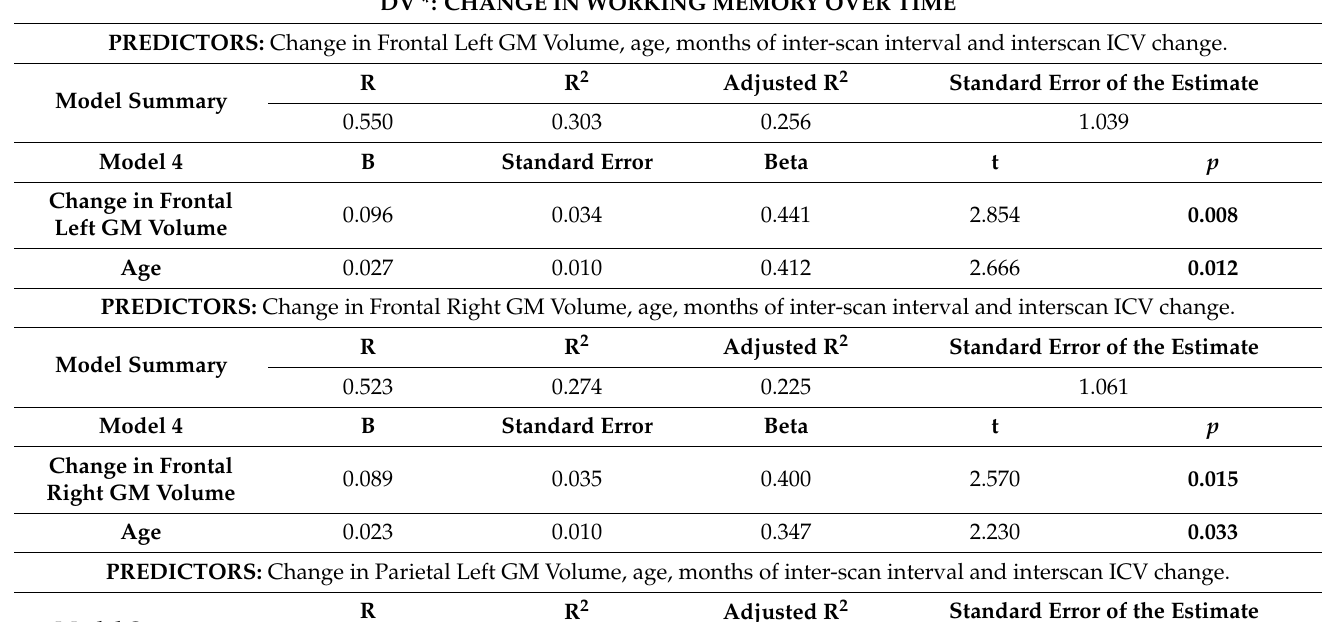
Table 3. Associations and predictive value of change in brain volume measures over change in cognitive performance at two year follow-up in EOP (final prediction models for significant backwards regression analyses are displayed—see Methods). DV *: CHANGE IN WORKING MEMORY OVER